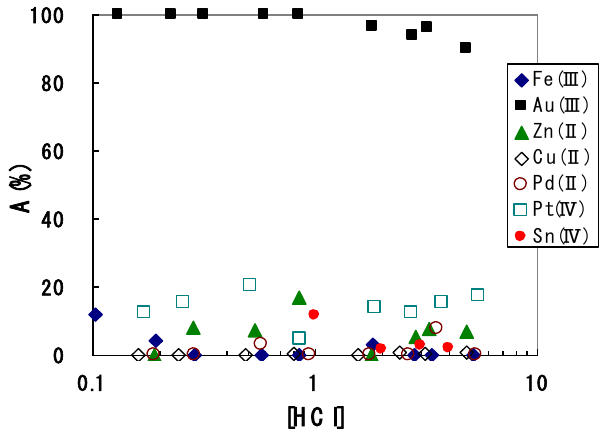
Figure 25. Percentage adsorption of some metal ions on PP gel from varying concentration (mol·dm −3 ) of hydrochloric acid [34] (with permission for reuse from Elsevier